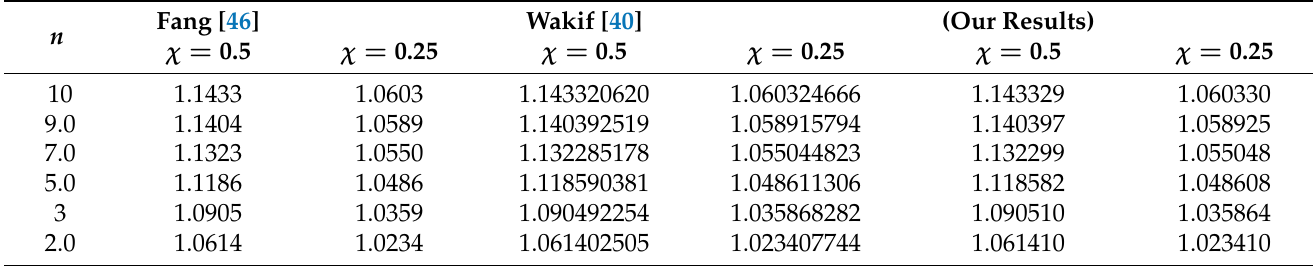
Table 2. Comparing the current numerical findings for Pr when and all others parameter are zero.